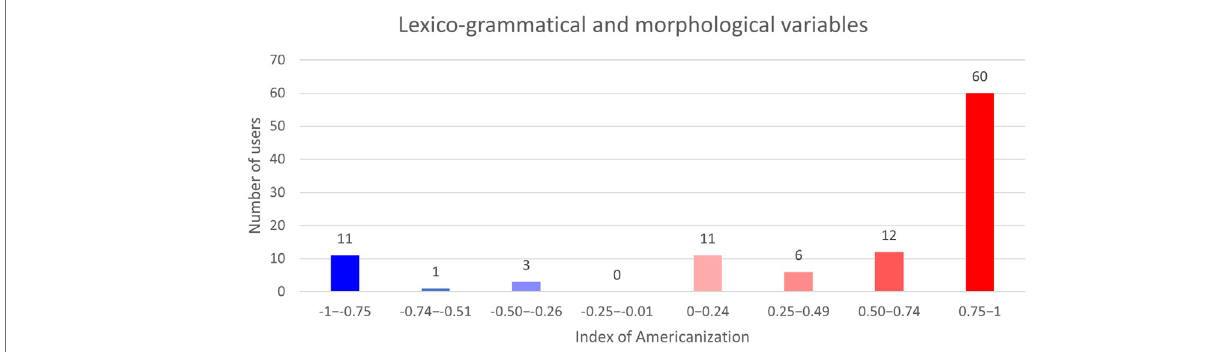
FIGURE 3 | All users ’ indexes of Americanization involving all grammatical features (104 users).